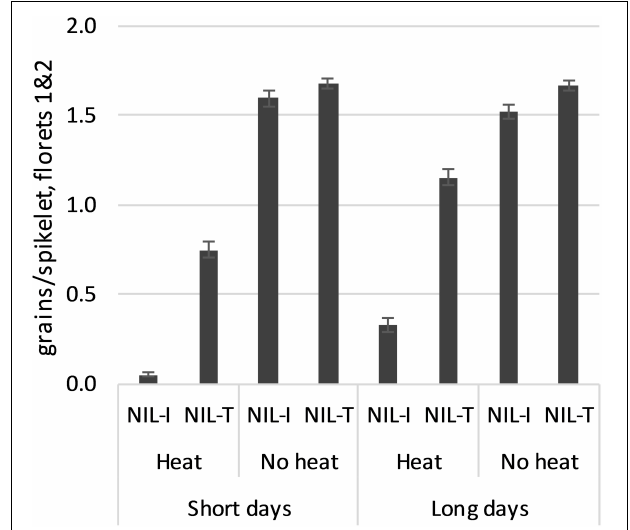
FIGURE 4 | Floret fertility (floret positions 1 and 2; means ± SE) in WtmsDW near-isogenic lines, NIL-I (Drysdale allele, intolerant) and NIL-T (Waagan allele, tolerant). All means were significantly different at p < 0.001 except among the “No heat”